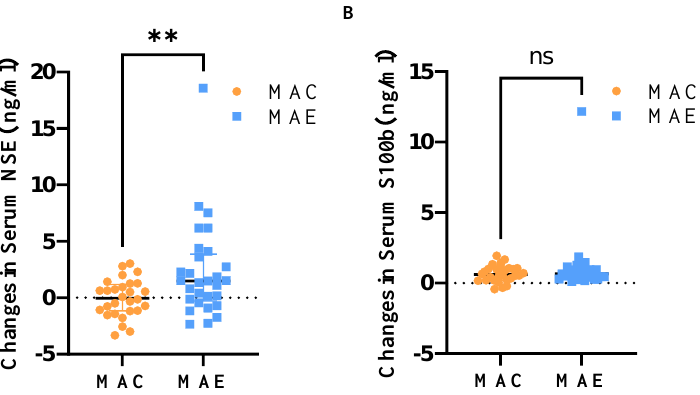
Figure 3. Amount of change in serum NSE and S100b in MAC and MAE groups before and after exercise intervention. ( A ): Amount of change in Serum NSE in MAC and MAE groups before and after exercise intervention.; ( B ): Amount of change in Serum S100b in MAC and MAE groups before and after exercise intervention. **: There was a significant difference in the amount of change in serum S100b before and after the exercise intervention in the MAE group compared to the MAC group; ns: Compared with the MAC group, there was no significant difference in the amount of change in serum NSE in the MAE group before and after the exercise intervention .